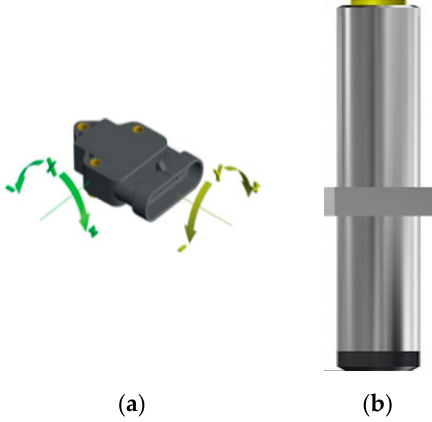
Figure 10. The physical appearance of SGBINs as ( a ) F-SGBINs and ( b ) C-SGBINs.